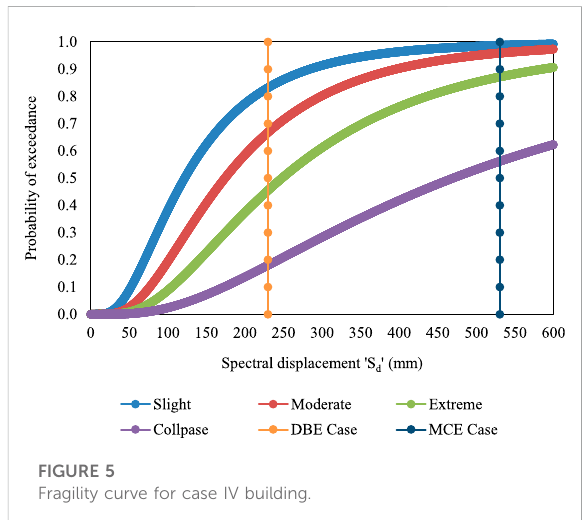
Different types of recovery paths (RP-1 to RP-5).